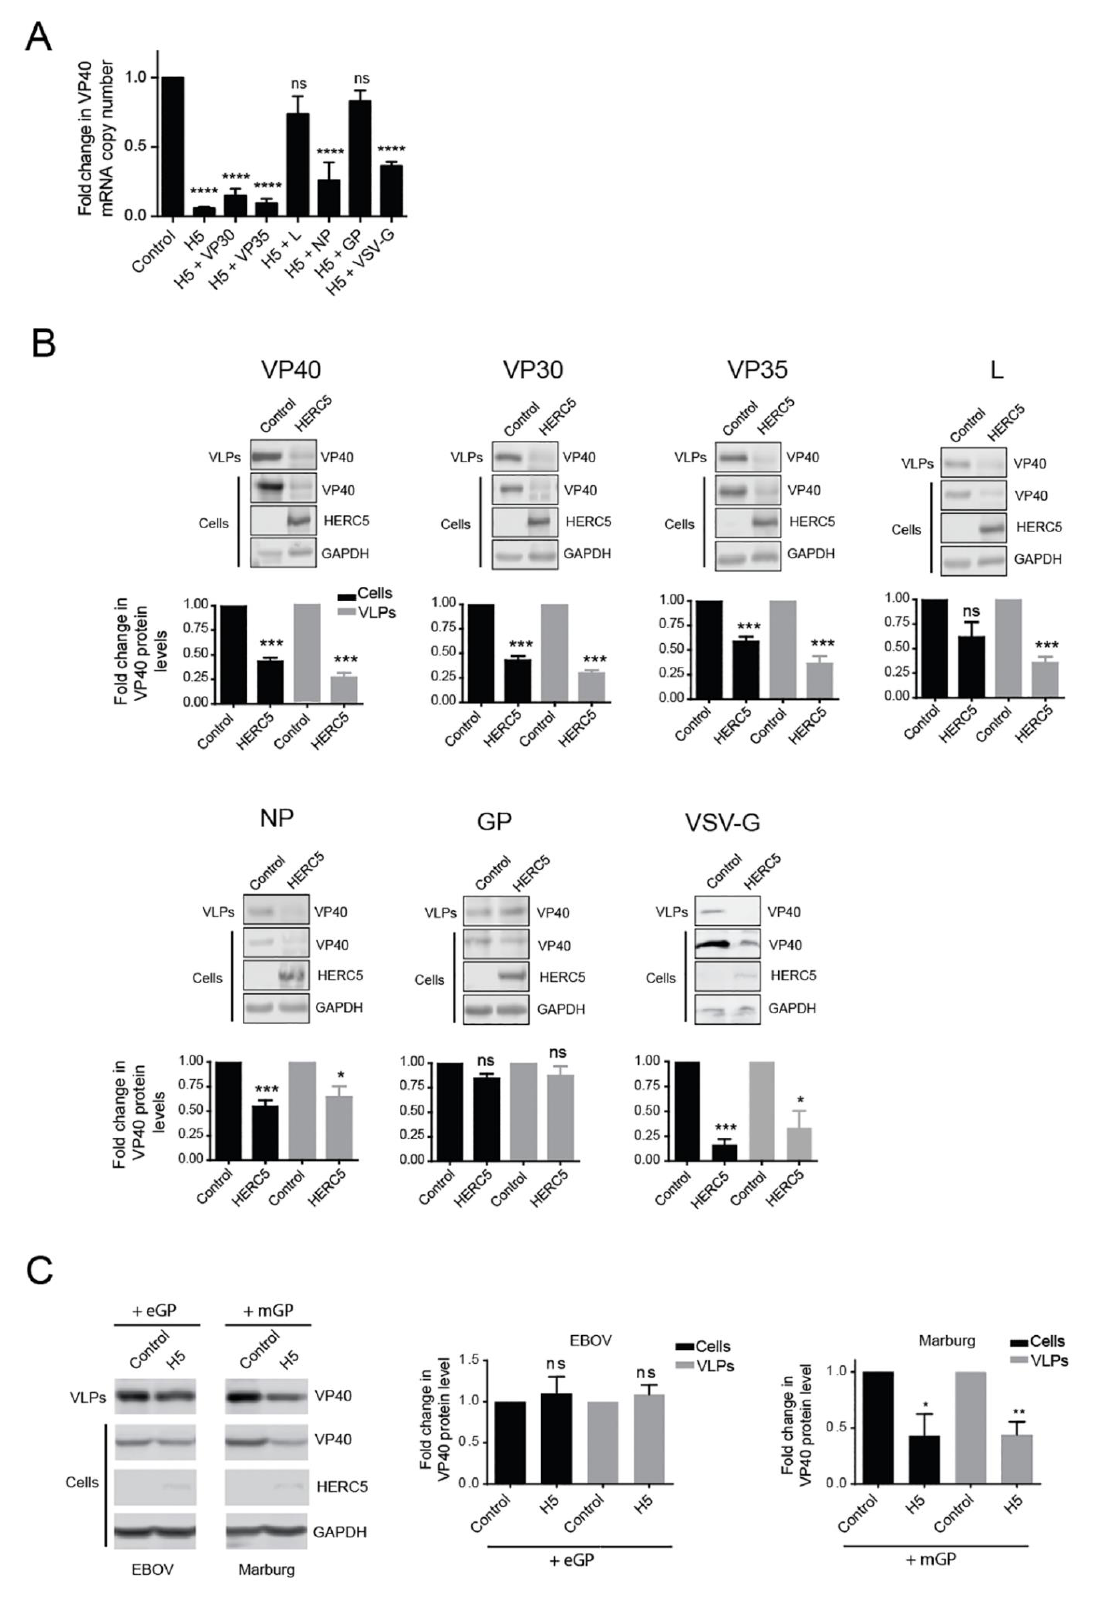
Figure 5. EBOV GP and L antagonize HERC5. 293T cells were co-transfected with plasmids carrying FLAG-tagged VP40 and either empty vector or HERC5 and one plasmid carrying either EBOV VP30, VP35, L NP, GP or VSV-G. Forty-eight